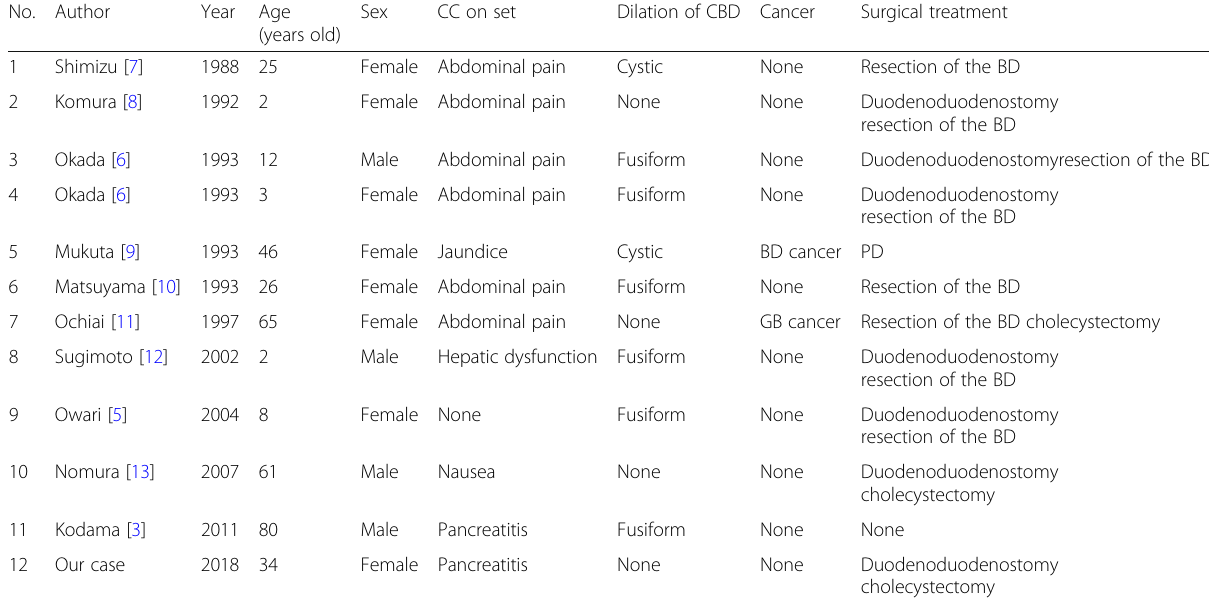
Table 1 Summary of patients of annular pancreas concurrent with pancreaticobiliary maljunction reported in Japan No.